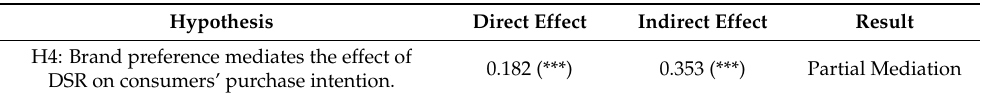
Table 5. The mediation analysis results.